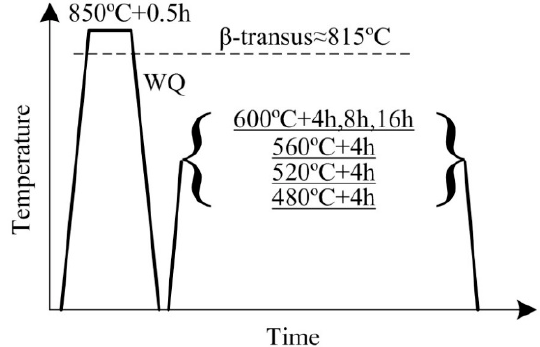
Figure 2. Schematic illustration of the heat treatment.